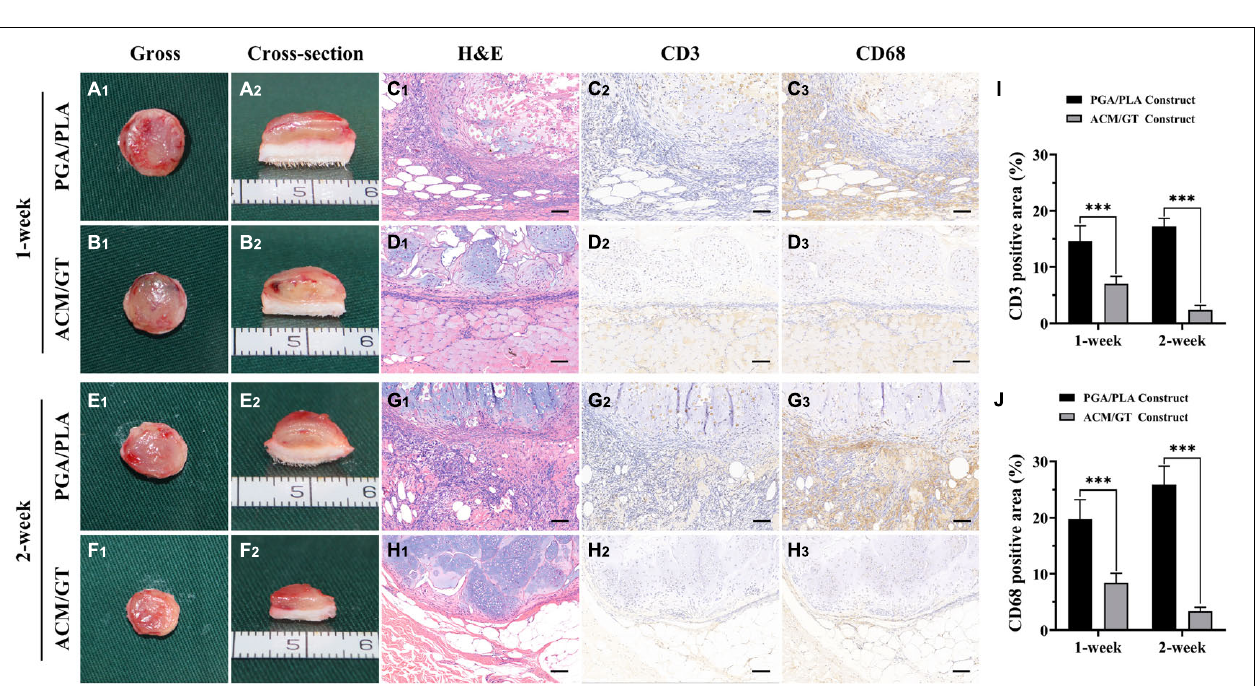
FIGURE 4 | The immune-inflammatory response evaluations of the cell-scaffold constructs subcutaneously implanted for 1 and 2 weeks. Gross and cross-section observation of the cell-PGA/PLA construct and cell-ACM/GT construct which subcutaneously implanted for 1 week (A,B) and 2 weeks (E,F) . Two groups of implanted samples with surrounding tissue were stained with H&E, CD3, and CD68 for immune-inflammatory response analysis (C,D,G,H) and the quantification of the CD3 (I) and CD68 (J) position area (%). Scale bar: 100 µ m. Statistical significance: ∗∗∗ p < 0.001.